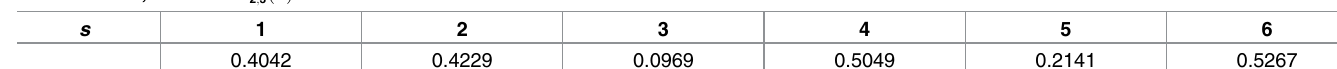
Table 8. M = 2, model 3: ^ P ð s Þ